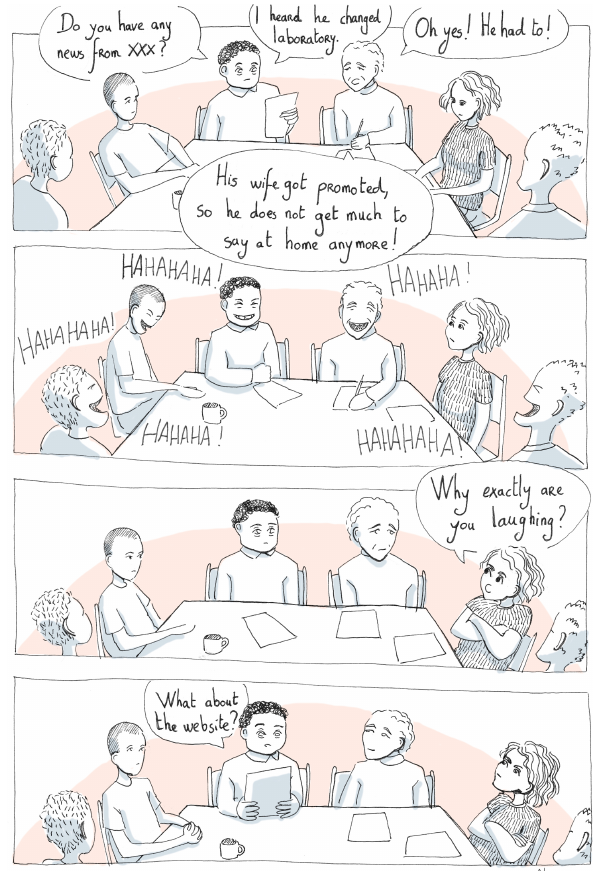
Figure 4. Example of “Male stereotypes” and “Women as outsiders in networking contexts” categories. Peers are laughing at a male col- league who supports his wife’s career evolution. At the same time, a female scientist finds herself outside of the male fraternity circle. Comic strip title: “His wife got promoted” (DTRH team, 2019a; Adenis, 2019). All comics are hand-drawn by Alice Adenis – dis- tributed under the Creative Commons Attribution 4.0